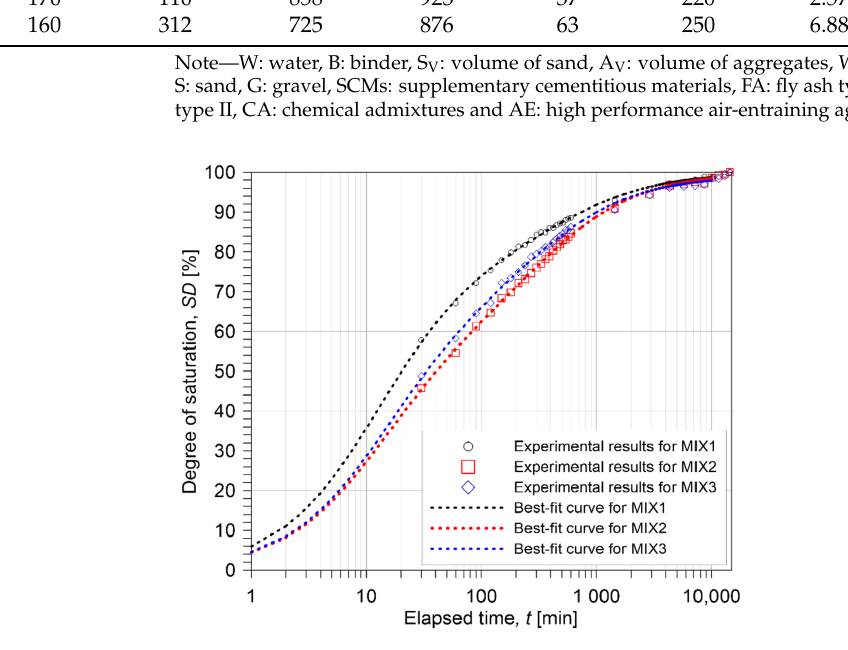
Figure 1. The curve of water saturation with stages in water saturation trend: variation of saturation of the three concrete types (MIX 1, 2 and 3) in linear time scal e. Table 3. Summary of constant coefficients for the estimated saturation curves determined by non- linear regression analysis.